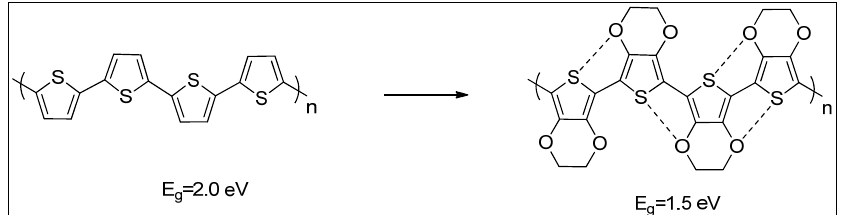
Figure 16. Intermolecular interactions between EDOT molecules.